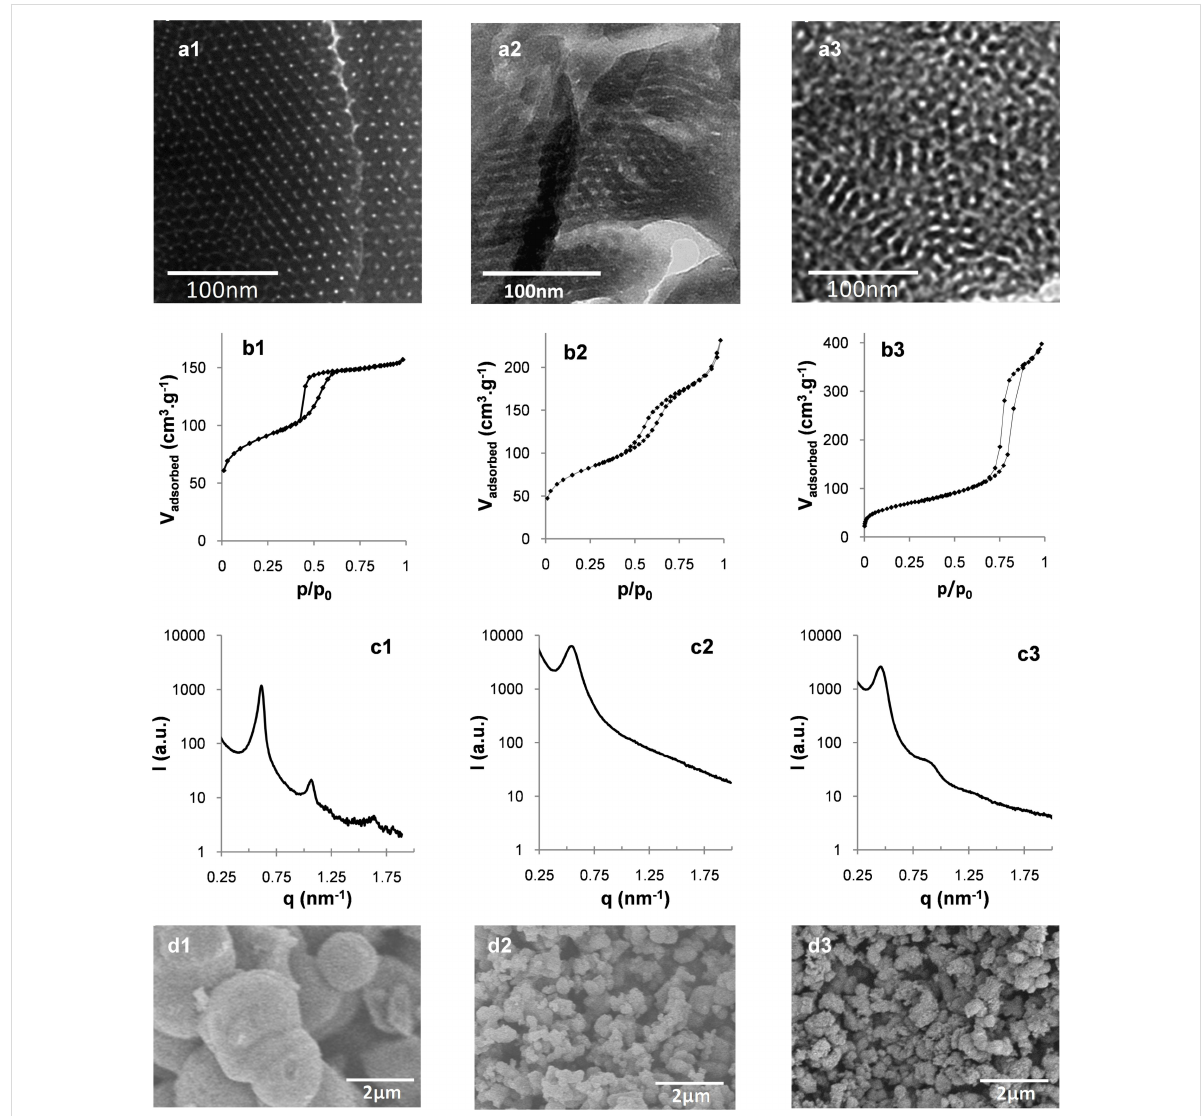
Figure 2: TEM micrographs (a), N 2 adsorption/desorption isotherms (b), SAXS patterns (c) and SEM images (d) of the calcined materials synthe- sized with 3.9 wt % DHBC at pH 4.5 (d1), 6.5 (d2) and 7.9